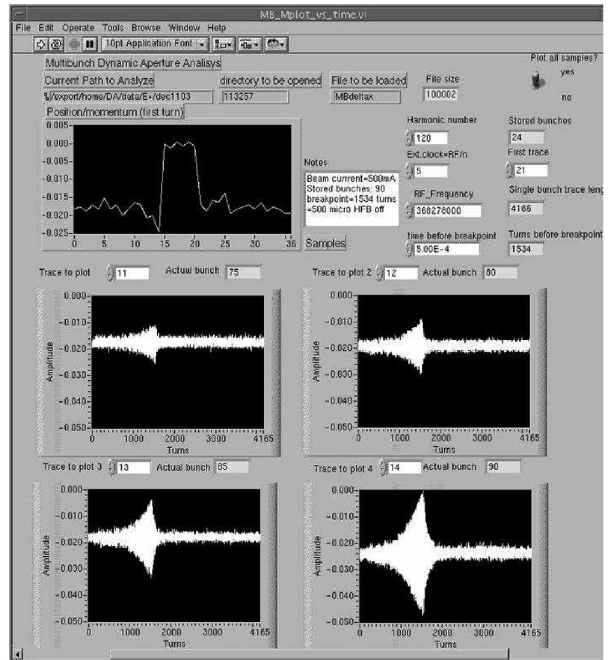
FIG. 33. Grow-damp measurement of horizontal oscillations for bunches 75, 80, 85, and 90 at DAFNE in 2004 [39]; the feedback was switched off for a short time; 90 consecutive bunches were followed by a gap of 30 missing bunches.